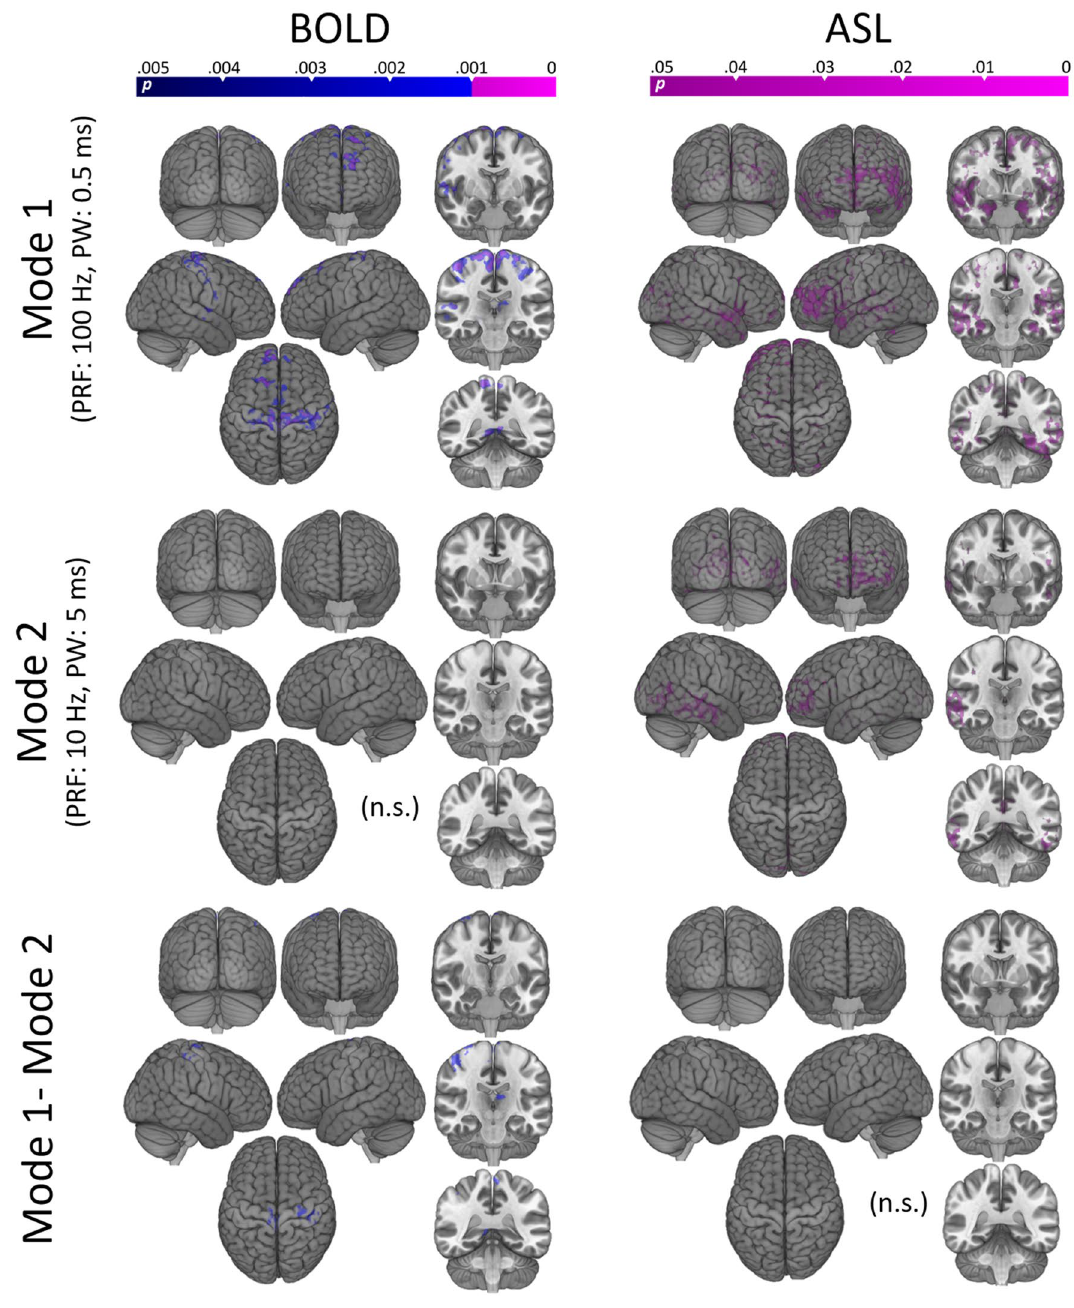
Figure 4. Whole brain results. Left: Regions of significant decrease in BOLD signal during sonication Mode 1 (top) and Mode 2 (middle) compared to inter-sonication periods (i.e., baseline). Subtraction of these results are also shown (bottom). Statistical maps were obtained using a mixed effects model (FLAME 1 + 2) as implemented in FSL 69 , and are shown at two levels of cluster correction for multiplicity (CDT set at p < 0.005, in blue, and at p < 0.001 in violet). Significant reduction in BOLD is found in several cortical regions, at both thresholds, for Mode 1. No regions of increased BOLD signal were observed for Mode 1. No regional increase or decrease was observed for Mode 2. Right: Regions of significant decrease in relative perfusion after sonication in Mode 1 (top) and Mode 2 (middle). Subtraction of these results are also shown (bottom). Statistical maps were obtained with a non-parametric approach (FSL randomise), as implemented in FSL, and are here shown at a level of p < 0.05 corrected for multiplicity with threshold free cluster enhancement (TFCE). No significant increase in ASL was observed for either sonication blood flow and acute neural activity, ASL quantifies cerebral blood perfusion alone. This reduces the inter-subject and inter-trial variability of ASL relative to BOLD 40 , making ASL preferable for detecting disparate neural activity between distant time points. Here, we again found an apparent inhibition (decreased perfusion) of our target